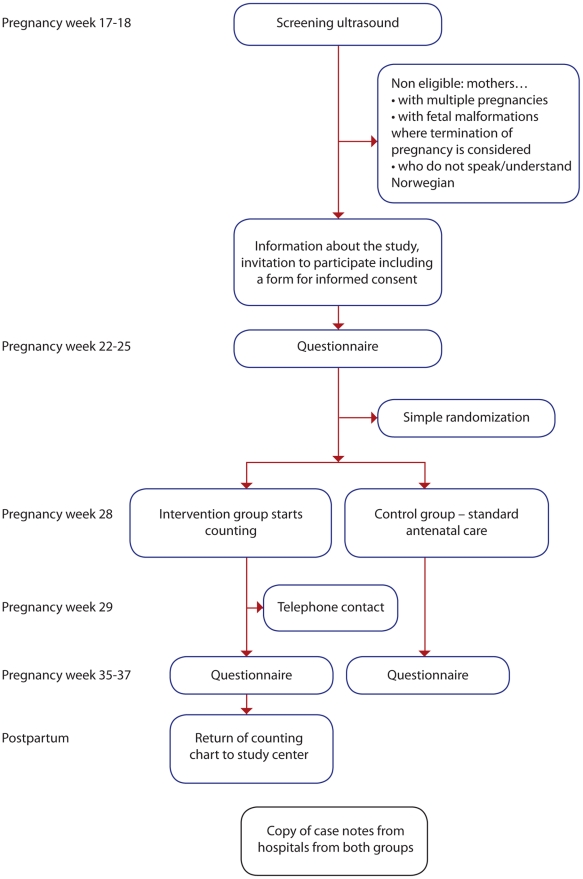
Flow chart data collection.